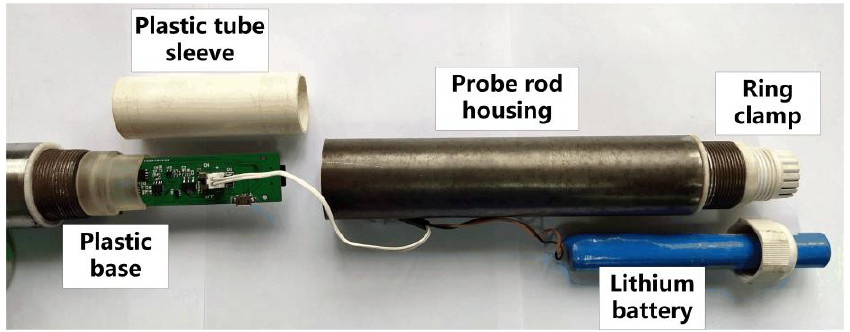
Figure 8. Probe rod assembly diagram.